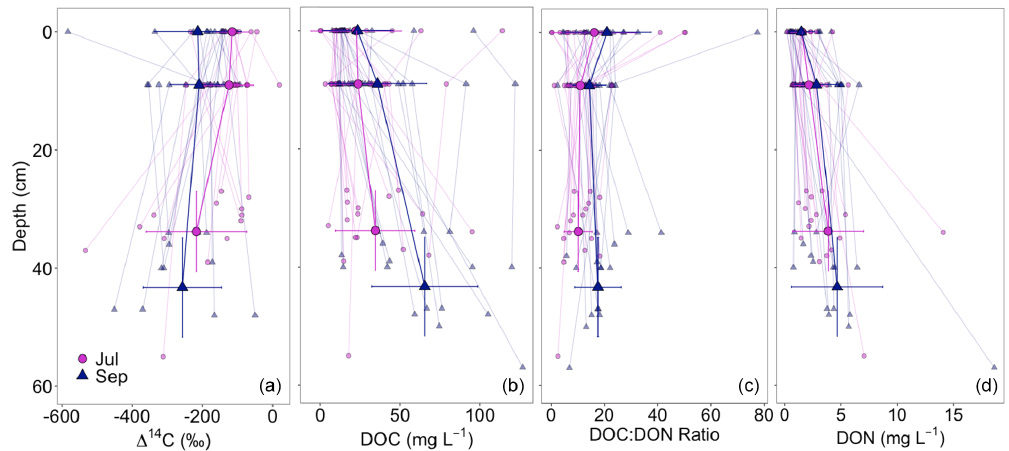
Figure 2. 14 C of DOC (a) , DOC concentration (b) , DOC : DON ratio by mass (g : g) (c) , and DON concentration (d) by depth. Large symbols are means ± SD. DOC and DON concentration data were presented previously Throckmorton et al. (2015b).